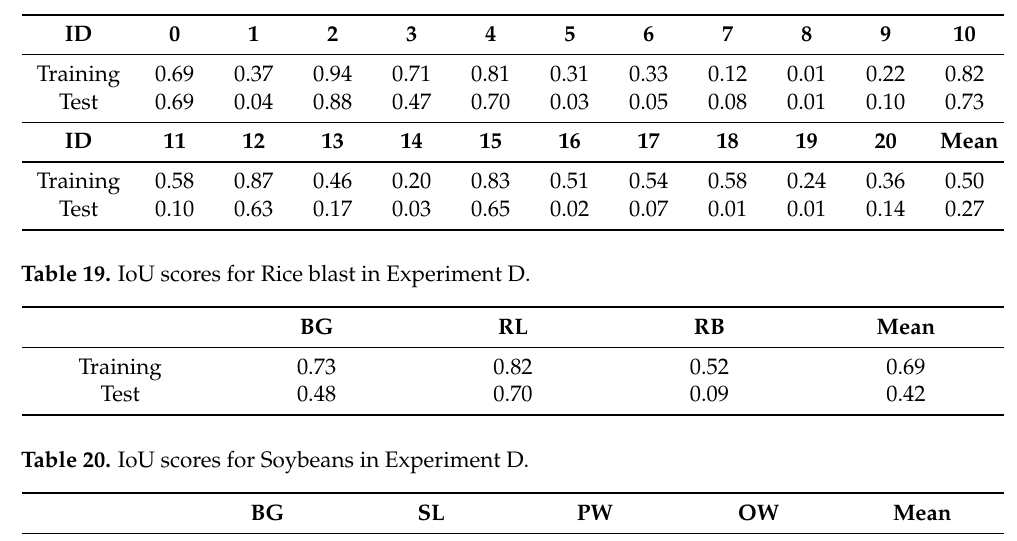
Table 18. IoU scores for Cityscapes in Experiment D.